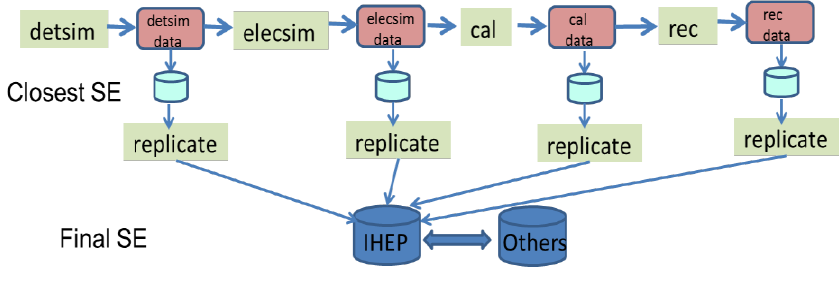
Fig. 4. JUNO workflow and dataflow in